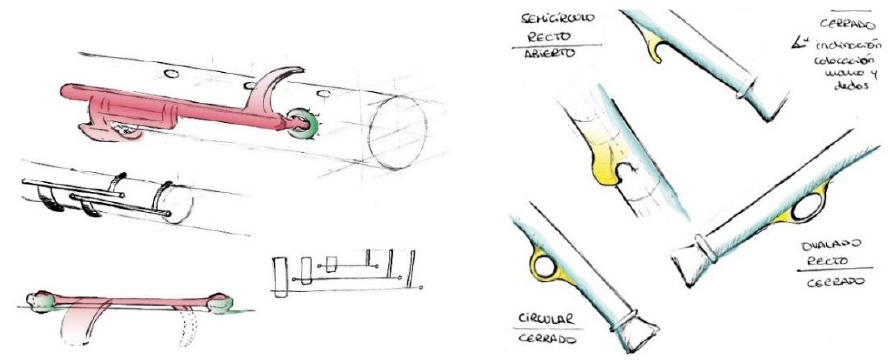
Figure 3. These sketches of Flow show the keys system and grip ring.